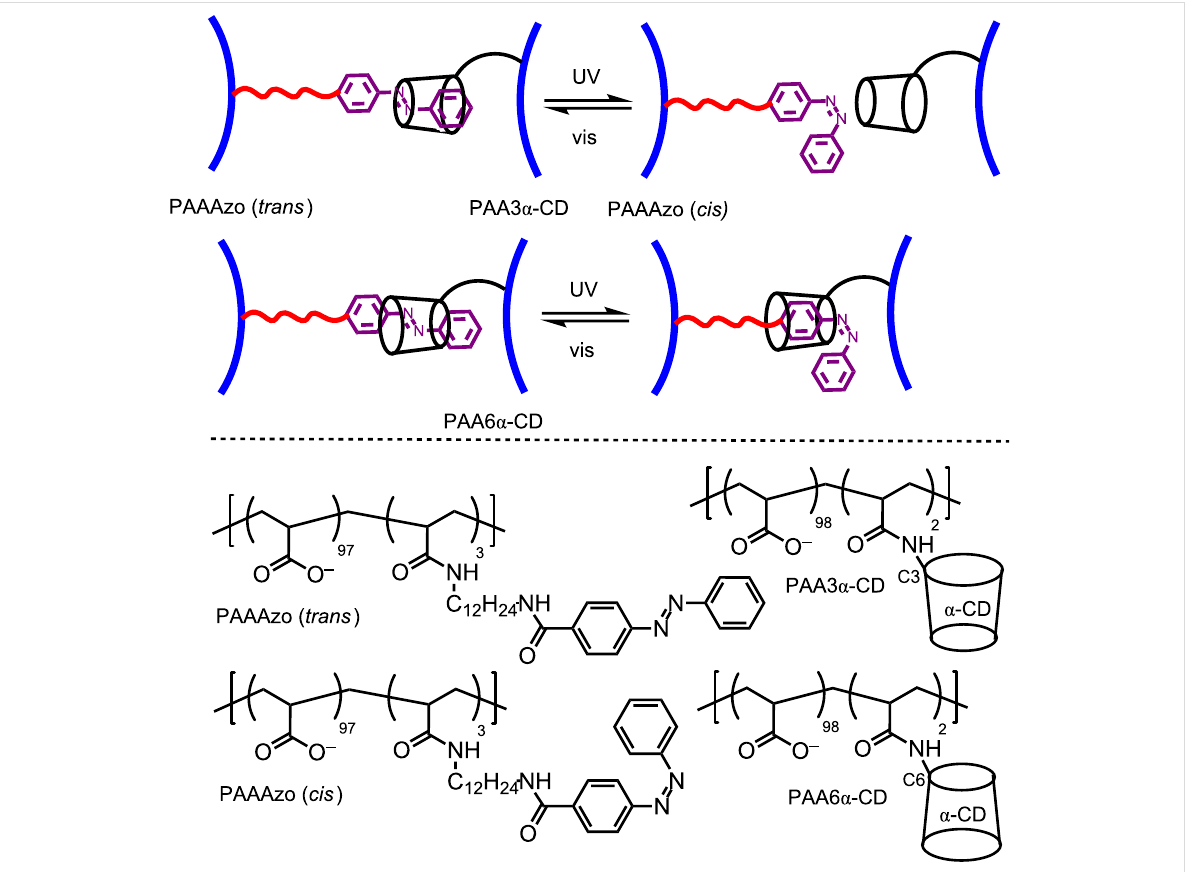
Figure 14: Structures of the poly(acrylate)-based polymers PAAAzo ( trans ), PAAAzo ( cis ), PAA3 α -CD and PAA6 α -CD, and the effects of the stereo- chemistry and photo-isomerism of the diazo substituents of PAA3 β -CD and PAA6 β -CD on their host–guest complexation by the α -CD substituents of PAA3 α -CD and PAA6 α -CD [67].